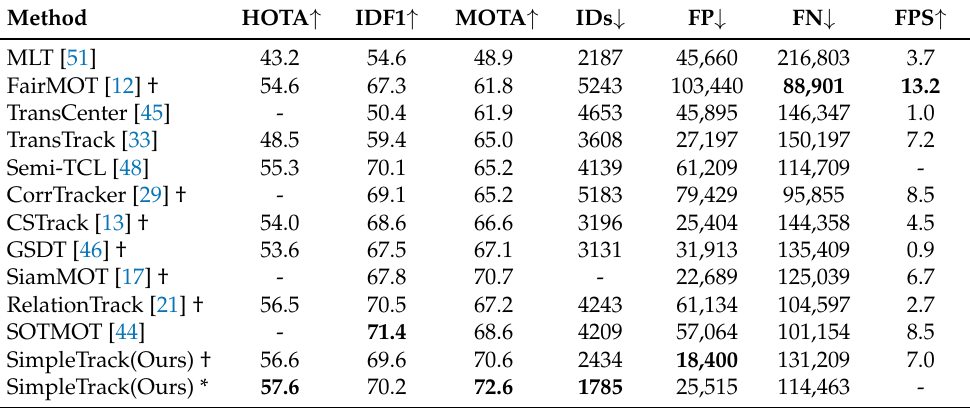
Table 3. Comparison of the state-of-the-art methods under the “private detector” protocol on the MOT20 test set. The best results are shown in bold . The scenes in MOT20 are much more crowded than those in MOT17. * indicates the addition of linear interpolation and † indicates JDE-based